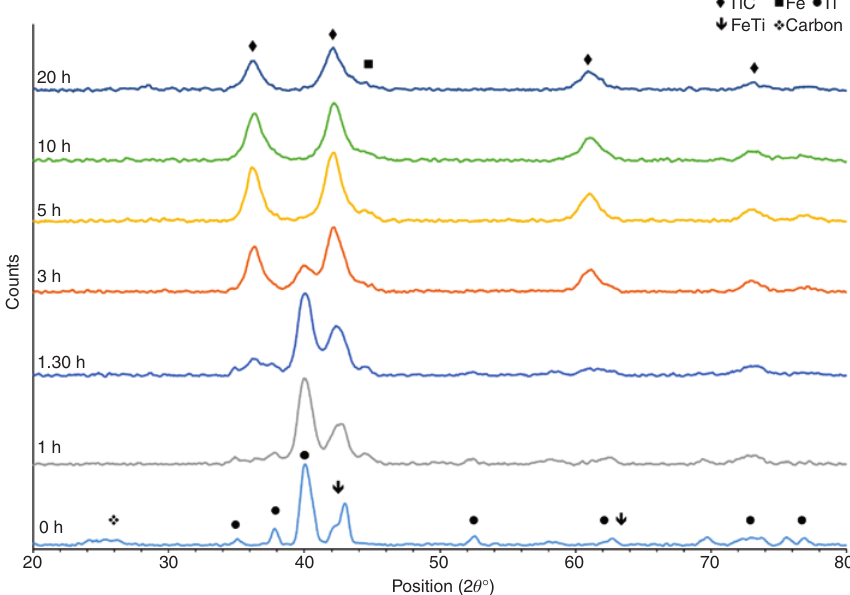
Figure 2: XRD pattern of Fe-TiC nanocomposite at different times.